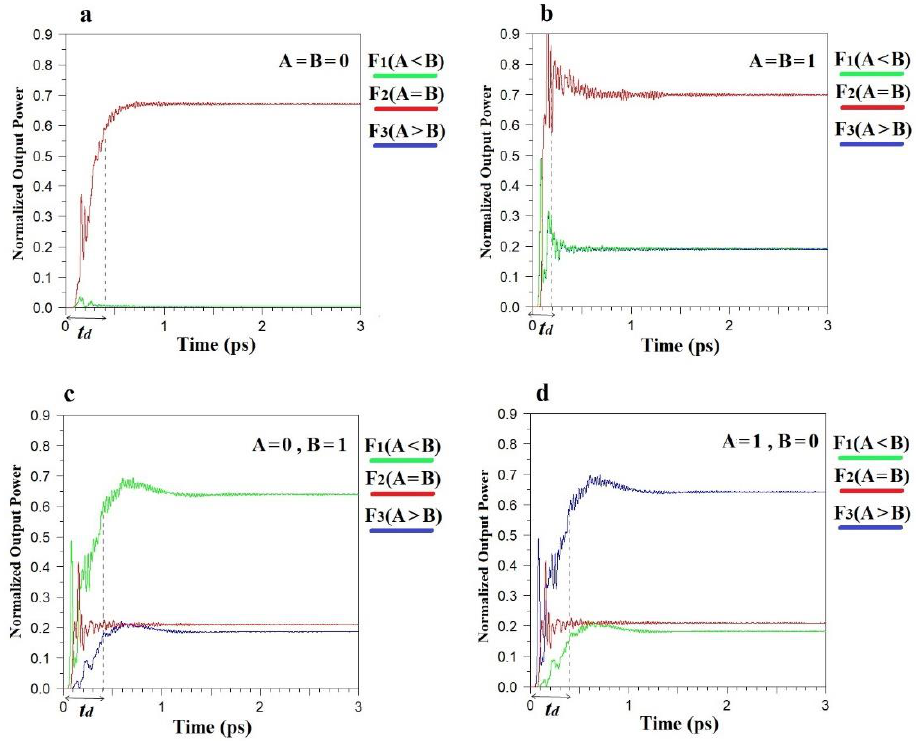
Figure 5. The normalized power diagram in the comparator outputs for different input states. ( a ) A = B = 0, ( b ) A = B = 1, ( c ) A = 0 and B = 1, ( d ) A = 1 and B = 0.